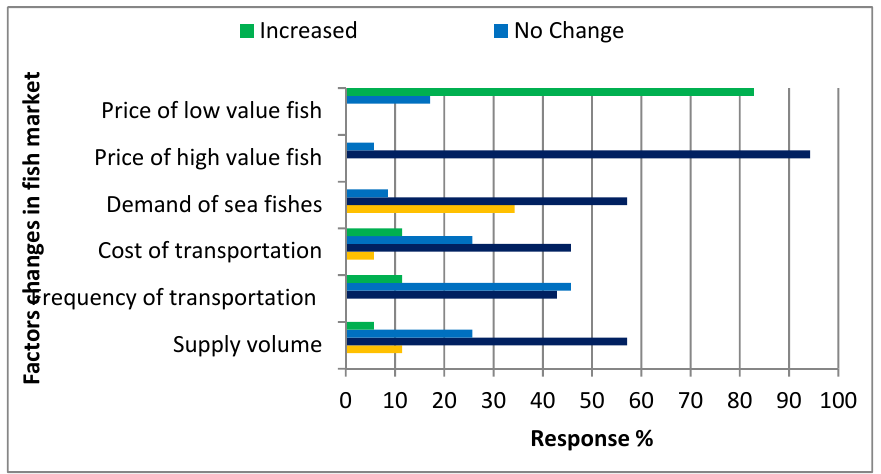
Figure 3. Perception of impacts of COVID-19 on wholesale chain of fish markets .